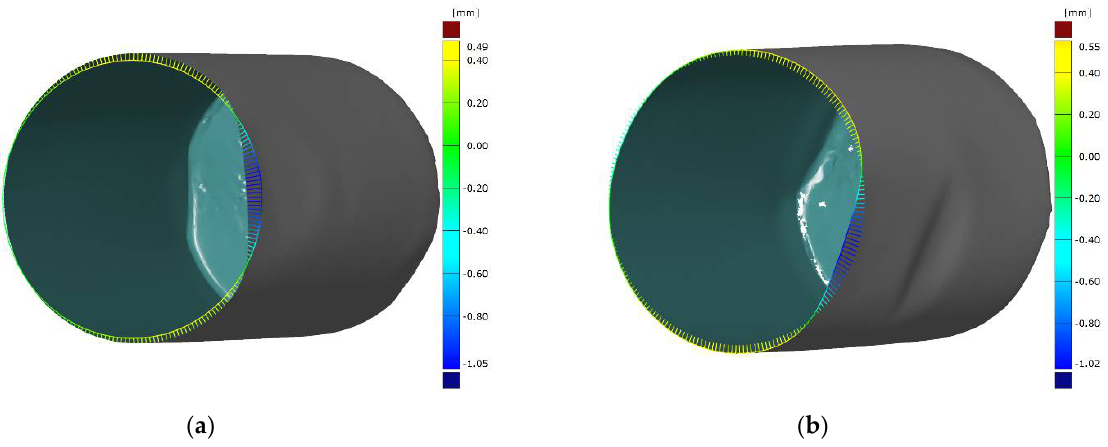
Figure 11. Section comparison scanned deformed battery vs. CAD data ( a ) first specimen section results and ( b ) second specimen section results.